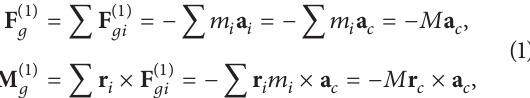
Figure 1: The model of cantilever beam with a tip-mass under base